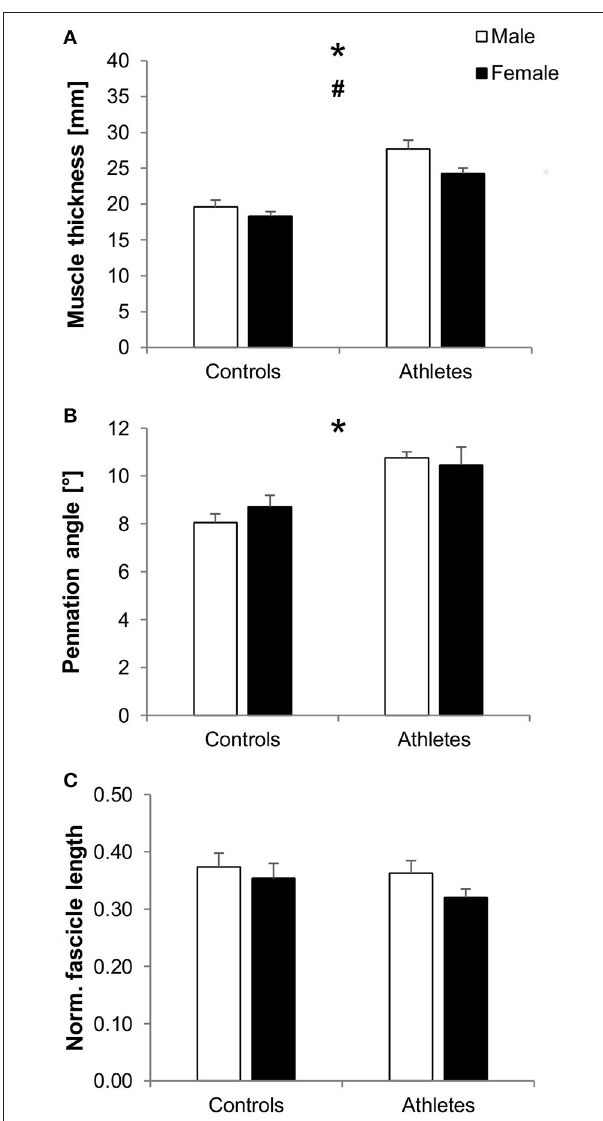
FIGURE 2 | Mean values and standard error (error bars) of vastus lateralis muscle thickness (A) , pennation angle (B) , and normalized fascicle length ( C ; normalized to femur length) of male (white) and female (black) adolescent controls and volleyball athletes. *Significant difference between athletes and controls, # significant difference between males and females, p < 0.05.